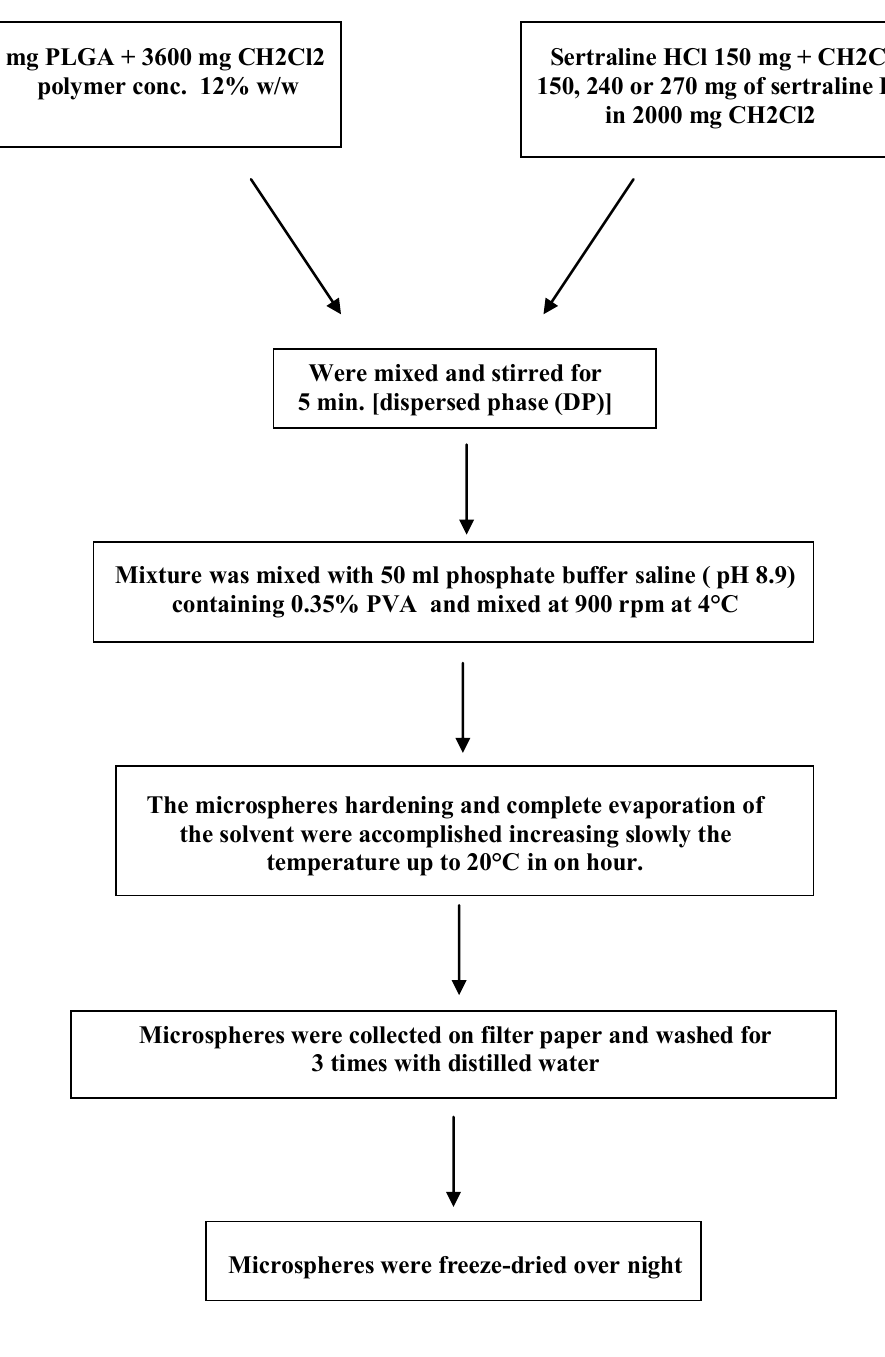
Figure 1: Preparation of PLGA Sertraline hydrochloride microspheres using dispersion/solvent extraction-evaporation